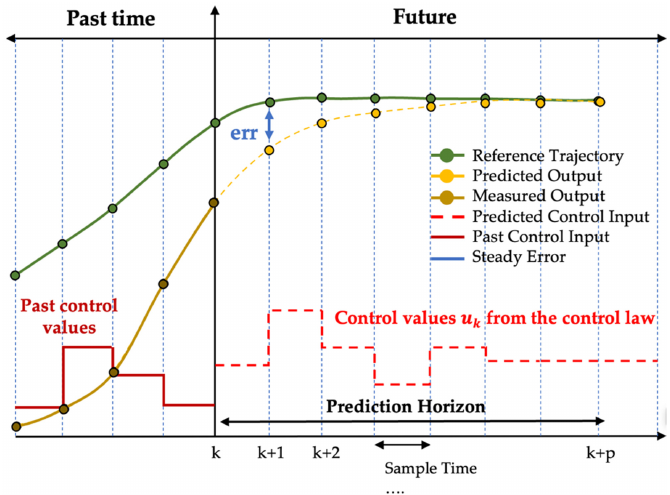
Figure 6. The concept of the internal actions of MPC [ 27].